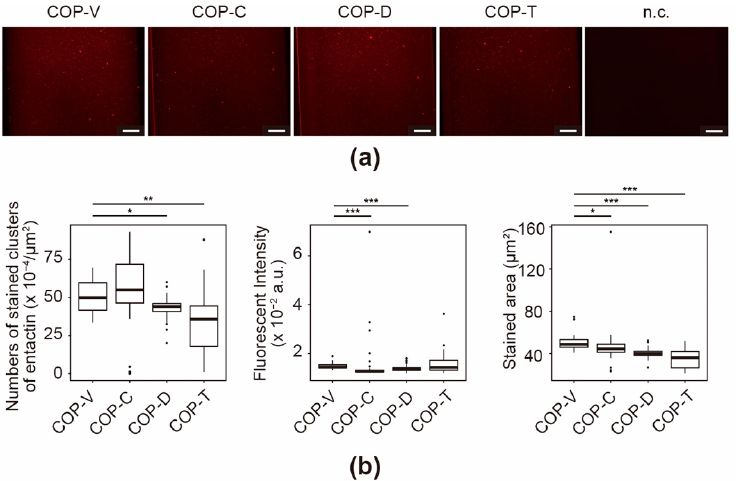
Figure 6. Immunofluorescence for entactin in Matrigel-coated cyclo-olefin polymer (COP) microfluidic channels. ( a ) Micrographs of immunostained entactin in Matrigel-coated COP microfluidic channels processed using vacuum ultraviolet (VUV) photobonding (COP-V) or solvent bonding with cyclohexane (COP-C), toluene (COP-T), or dichloromethane (COP-D). n.c. represents the negative control of a COP-V microfluidic channel coated with Matrigel and stained with a secondary antibody. Scale bars: 100 µm. ( b ) Quantitative analyses of the immunostained entactin in the Matrigel-coated COP microfluidic channels. The center lines indicate the median values; the box limits indicate the 25th and 75th percentiles; the whiskers extend to 1.5-times the interquartile range from the 25th and 75th percentiles; and outliers are represented by dots. Each experiment was repeated four times, and more than ten images of the COP devices from each experiment were used for quantification. * p < 0.05, ** p < 0.01, *** p < 0.005.